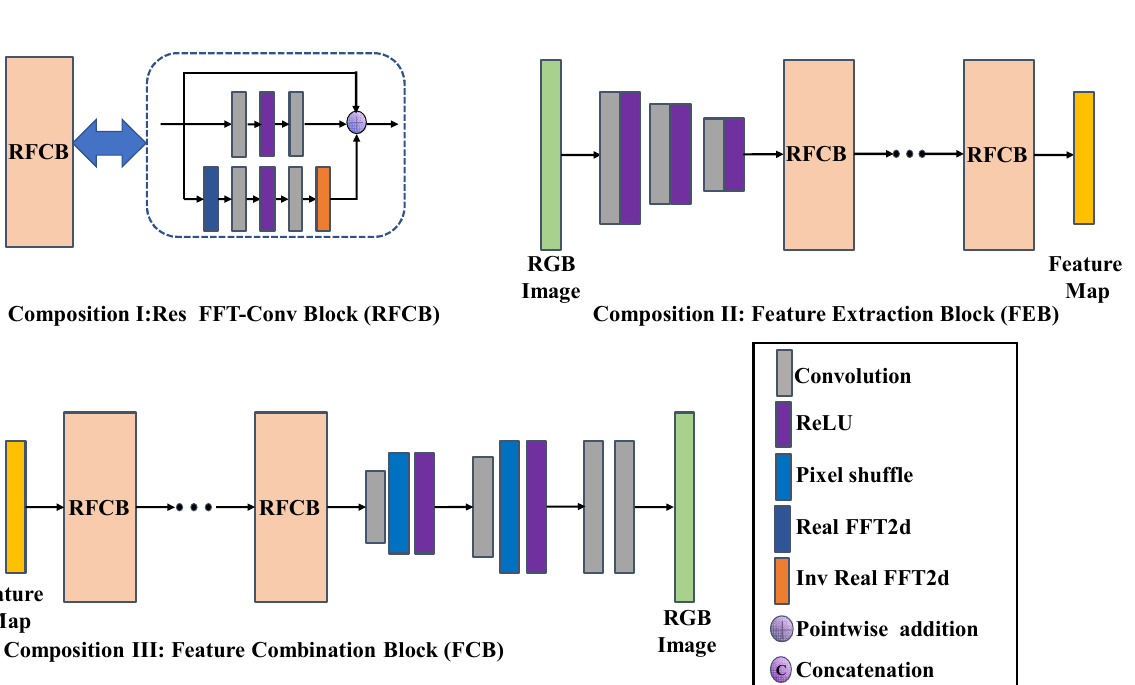
Figure 3. Structures of Res FFT-Conv Block (RFCB), feature extraction block (FEB), and feature combination block (FCB).